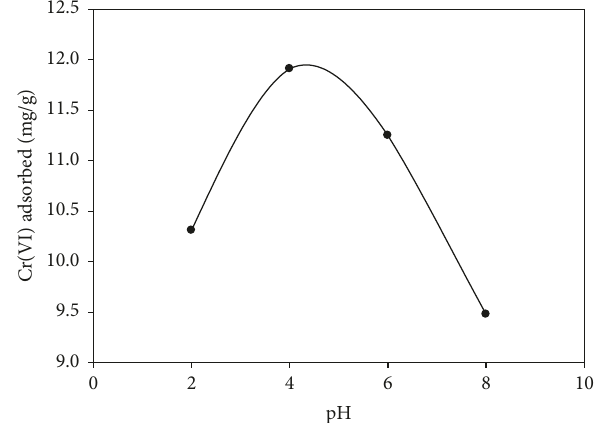
Figure 7: Effect of initial solution pH. Cr(VI) concen- tration 10 mg/L; T 25 2 ° (cid:31) (cid:31) ±